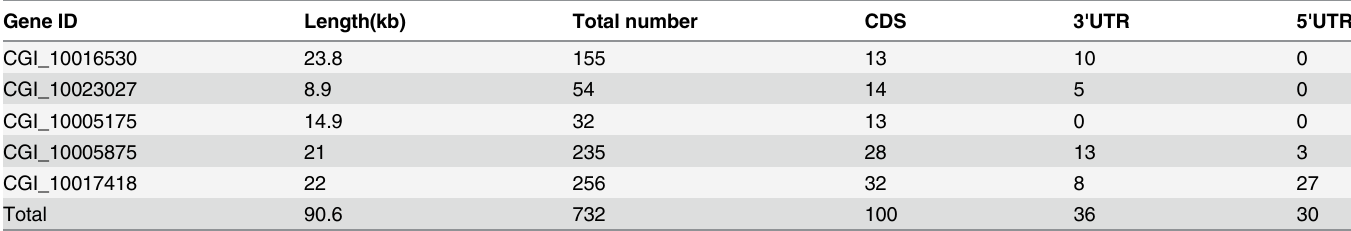
Table 2. The distribution of SNPs for each resequenced gene.